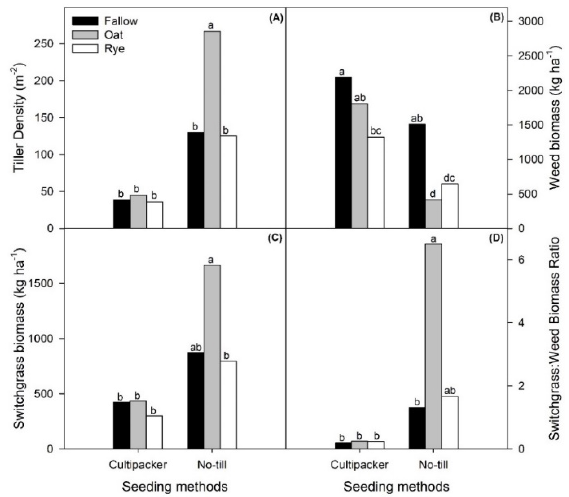
Figure 1. Effect of seeding method on switchgrass tiller density ( A ), weed biomass ( B ), switchgrass biomass ( C ) and switchgrass/weed biomass ratio ( D ) in the 2012 growing season. Data were averaged over Shawnee and CIR varieties (Experiment 1). Different letters at the tops of the columns represent significant differences ( p < 0.05) between the treatments. The interaction of cover crop with variety indicated that Shawnee, when planted in a fallow system, performed poorly (130 tillers m − 2 ) and significantly lower than CIR (225 tillers m − 2 ) when planted after oat (Figure